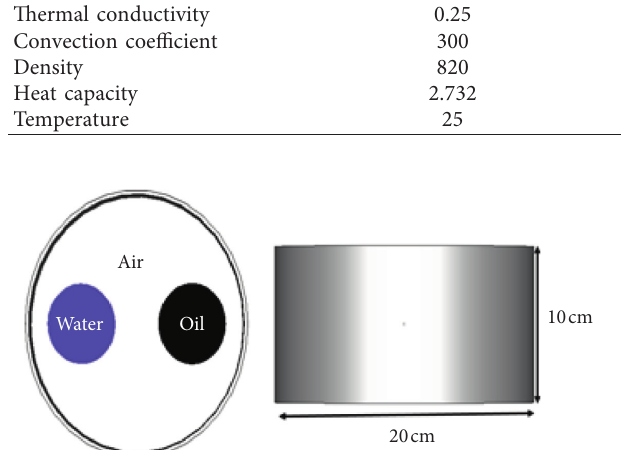
Figure 1: Pipeline model layout with its three main components of water, oil, and air.